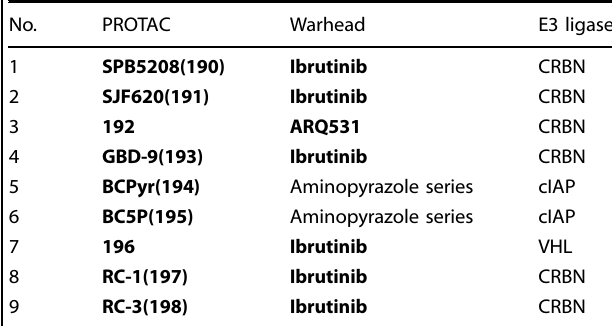
Table 6. The summary and comparison of PROTACs targeting